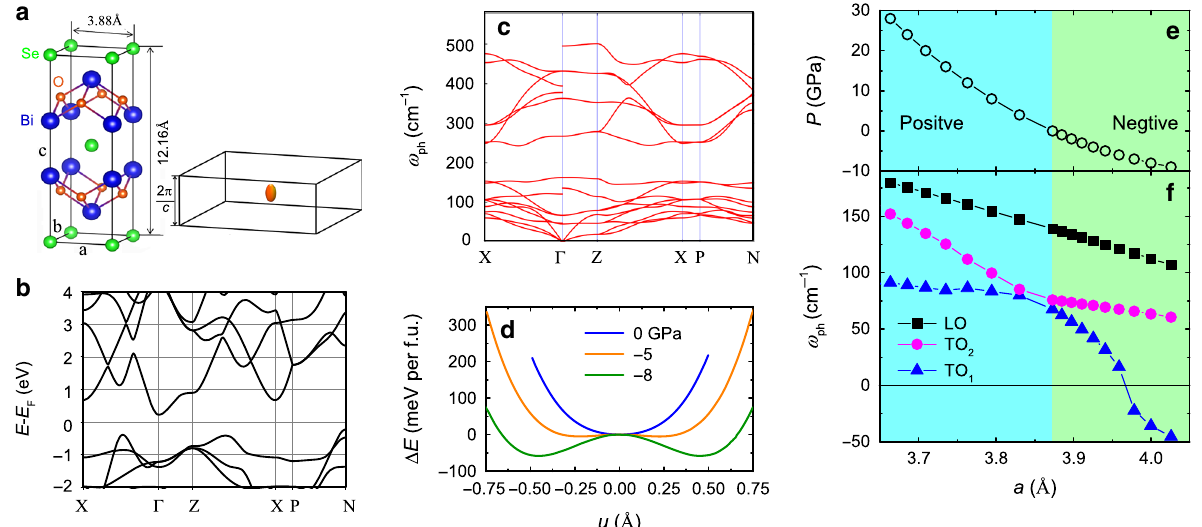
Fig. 1 Electronic and phonon properties of Bi 2 O 2 Se from fi rst-principle calculations. a Unit cell of the tetragonal phase and sketch of the ellipsoid Fermi surface at the Γ point of Brillouin zone. b Electronic band structures without spin-orbit coupling along high-symmetry lines of the Brillouin zone of the body- centered tetragonal unit cell. c Phonon dispersion at ambient pressure. d Local potential energy surface with respect to ion displacement along the lowest optical phonon mode, which changes from single-well to double-well by exerting large negative hydrostatic pressure. e One-to-one correspondence between the lattice parameter ( a ) and the hydrostatic pressure ( P ). f Frequency evolution of the three lowest optical modes with a , including two transverse modes: TO 1 (blue triangles) and TO 2 (magenta circles) and a longitudinal mode: LO (black squares) . The lattice constant at ambient pressure (3.873 Å ) is taken to be the optimized value from DFT calculations and the experimental lattice parameter is 3.88 Å